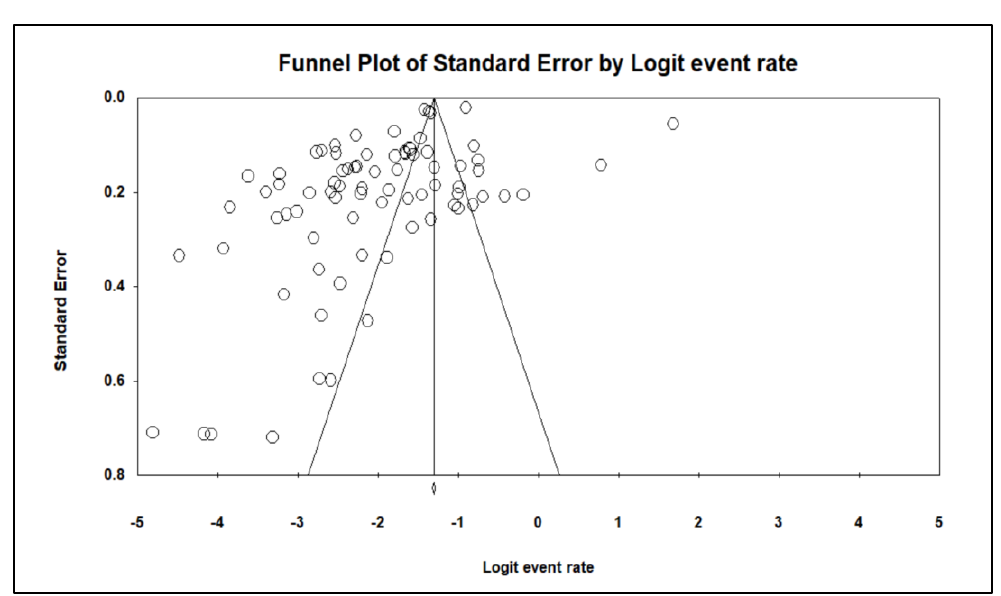
Figure 5. Publication bias of the seroprevalence of hepatitis E virus infection in Middle Eastern countries.